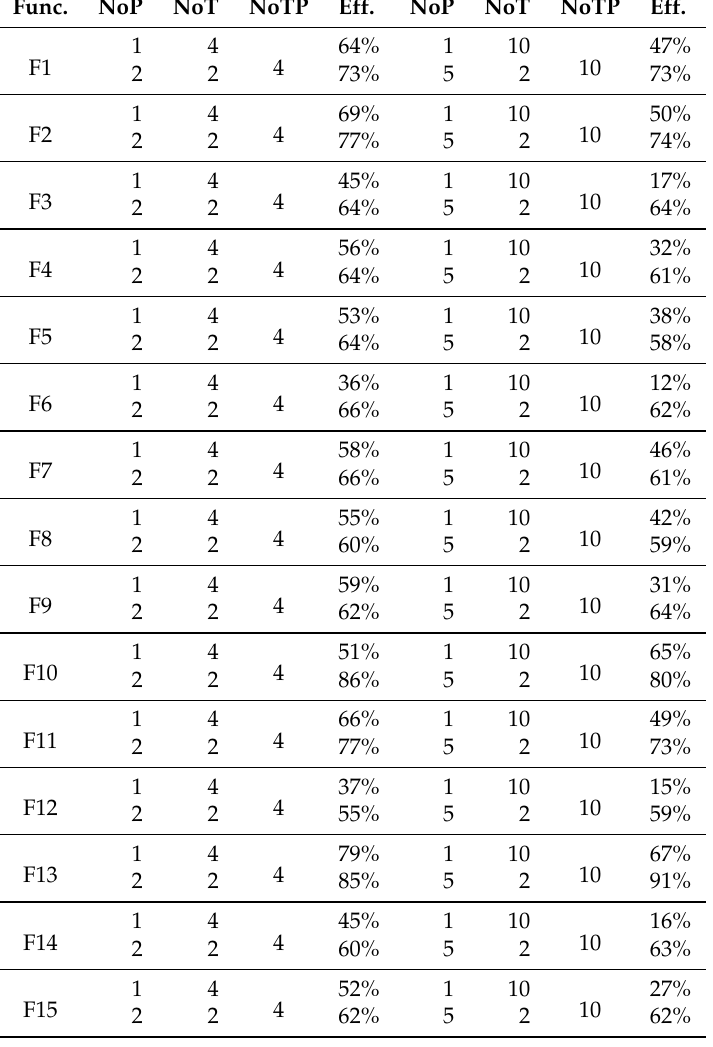
Table 4. Efficiencies for hybrid MPI/OpenMP parallel algorithm, Runs = 30, Population size = 240, Iterations =